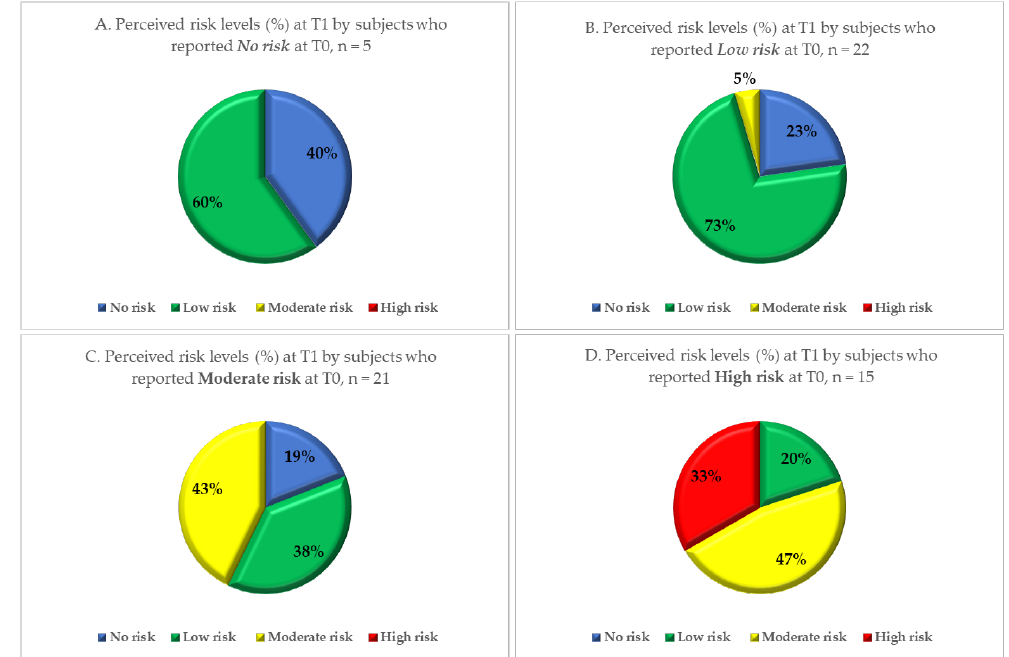
Figure 3. Level of perceived risk after among school staff ( n = 63) with no (Quadrant. A), low (Quadrant. B), moderate (Quadrant. C) and high (Quadrant. D) perceived risk at baseline, after the local health authority intervention.